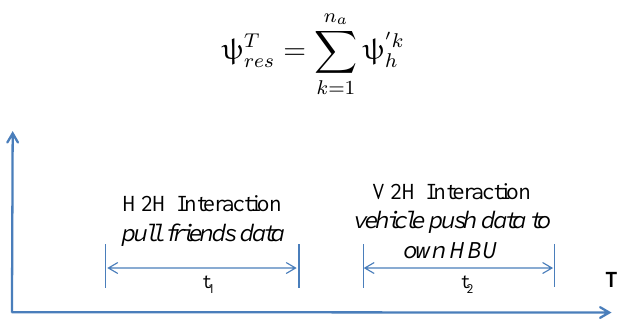
Figure 9. Event timeline of Home Base Unit (HBU) storage, ψ